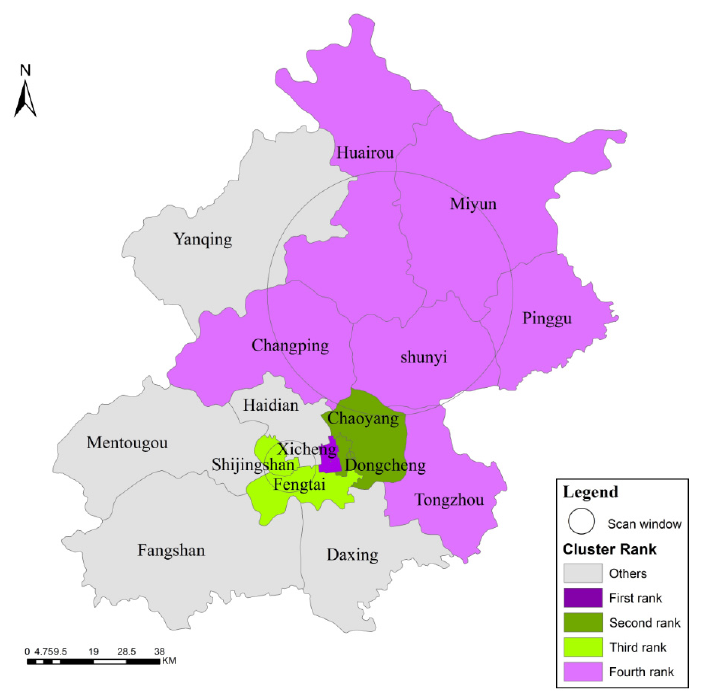
Figure 6. High and low IR spatio-temporal clusters in Beijing from 2009 to 2014.